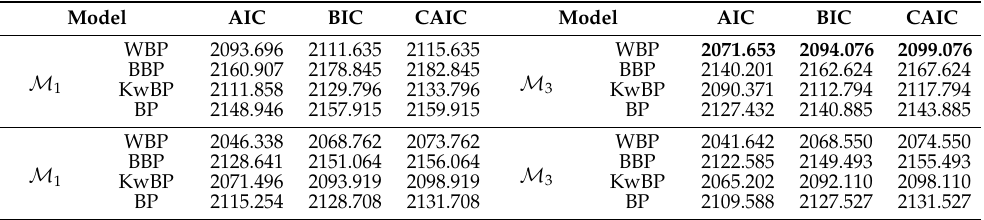
Table 7. Adequacy measures from regression models for COVID-19 data in Campinas.